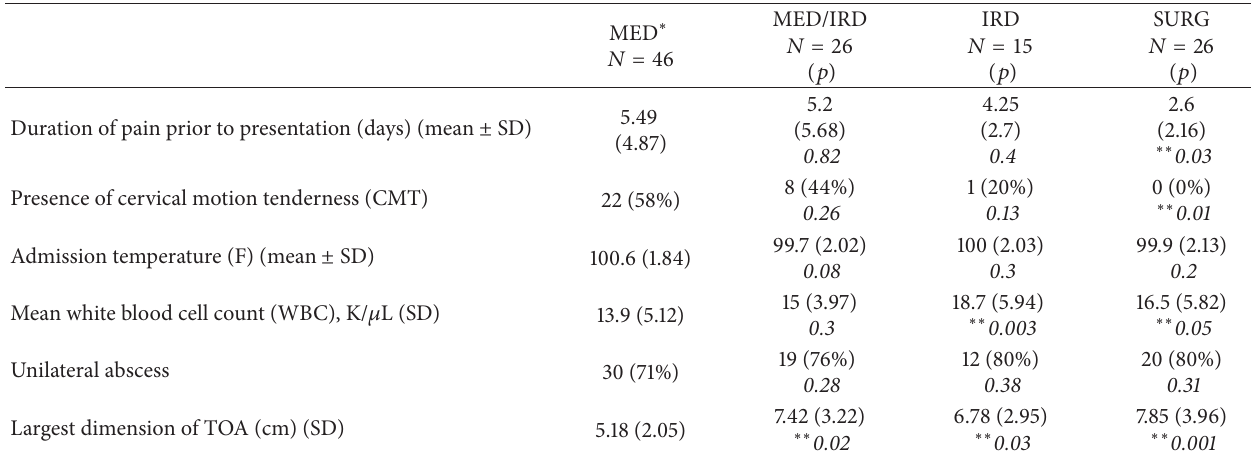
Table 2: Admission clinical characteristics by treatment